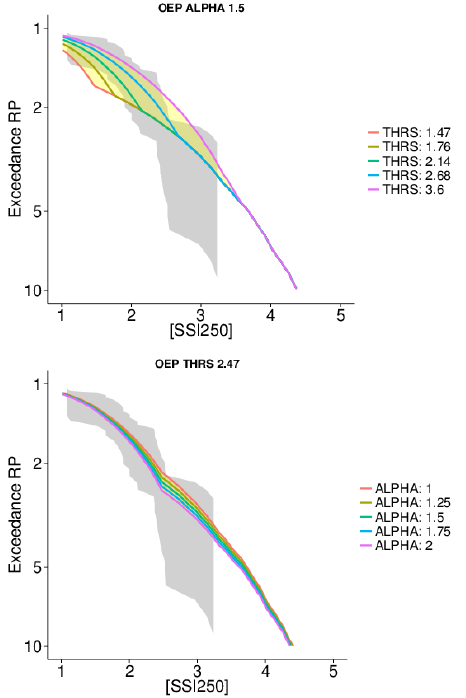
Figure 3. The upper and lower panels depict results arising from the clustered model calibration process. THRES represents the SSI250 threshold, whereas ALPHA indicates the gamma variance. The up- per panel depicts OEP curves from various model combinations with fixed gamma variance 1.5 and varying SSI250 threshold. The lower panel depicts OEP curves from various model combinations for fixed SSI250 2.47 threshold but varying gamma variance. The grey uncertainty bands are associated with the empirical OEP curve derived from the historical